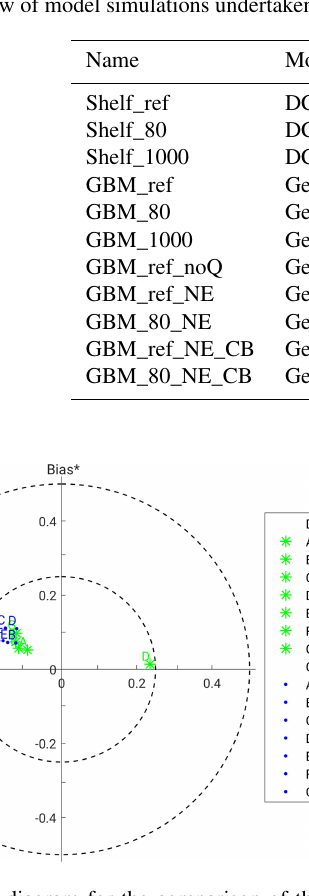
Figure 4. Target diagram for the comparison of the DCSMv6FM and the German Bight Model with measured water levels at seven stations along the German Bight (stations marked in Fig. 2). The numbers given are normalised by the standard